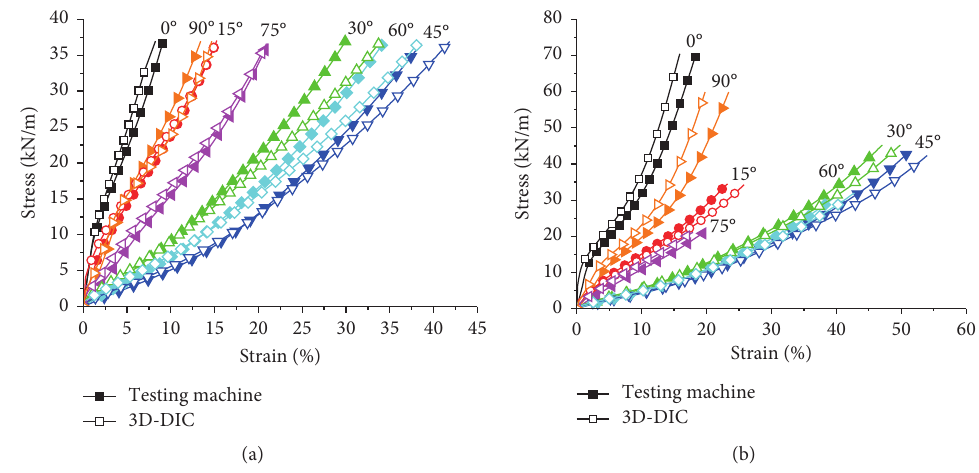
Figure 9: Stress–strain curves from the off-axis tensile tests. (a) Dumbbell shape. (b) Strip